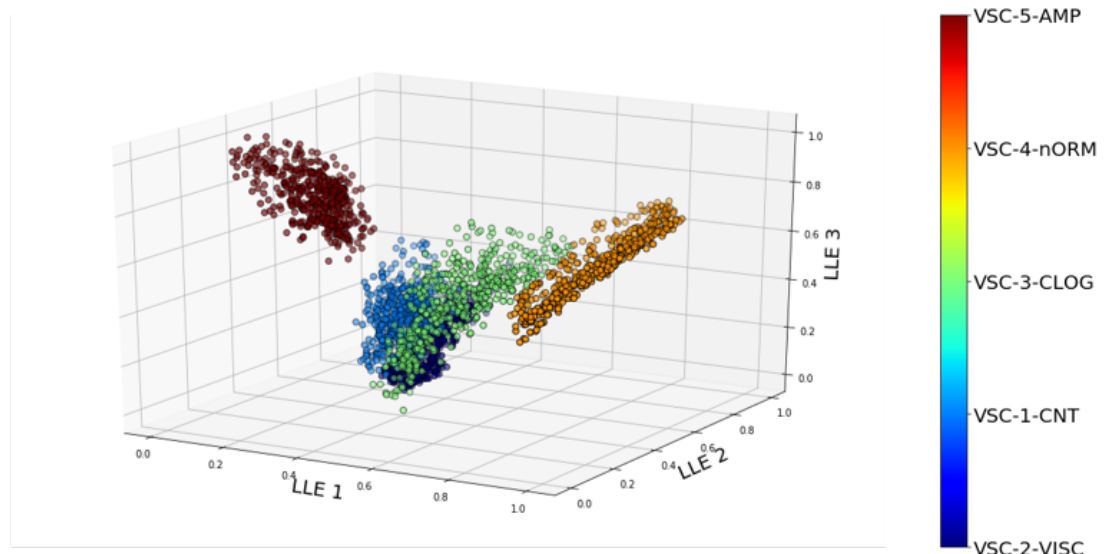
Figure 6. 3D-view of the locally linear embedding (LLE)-transformed features showing high discriminance ( NN = 15).